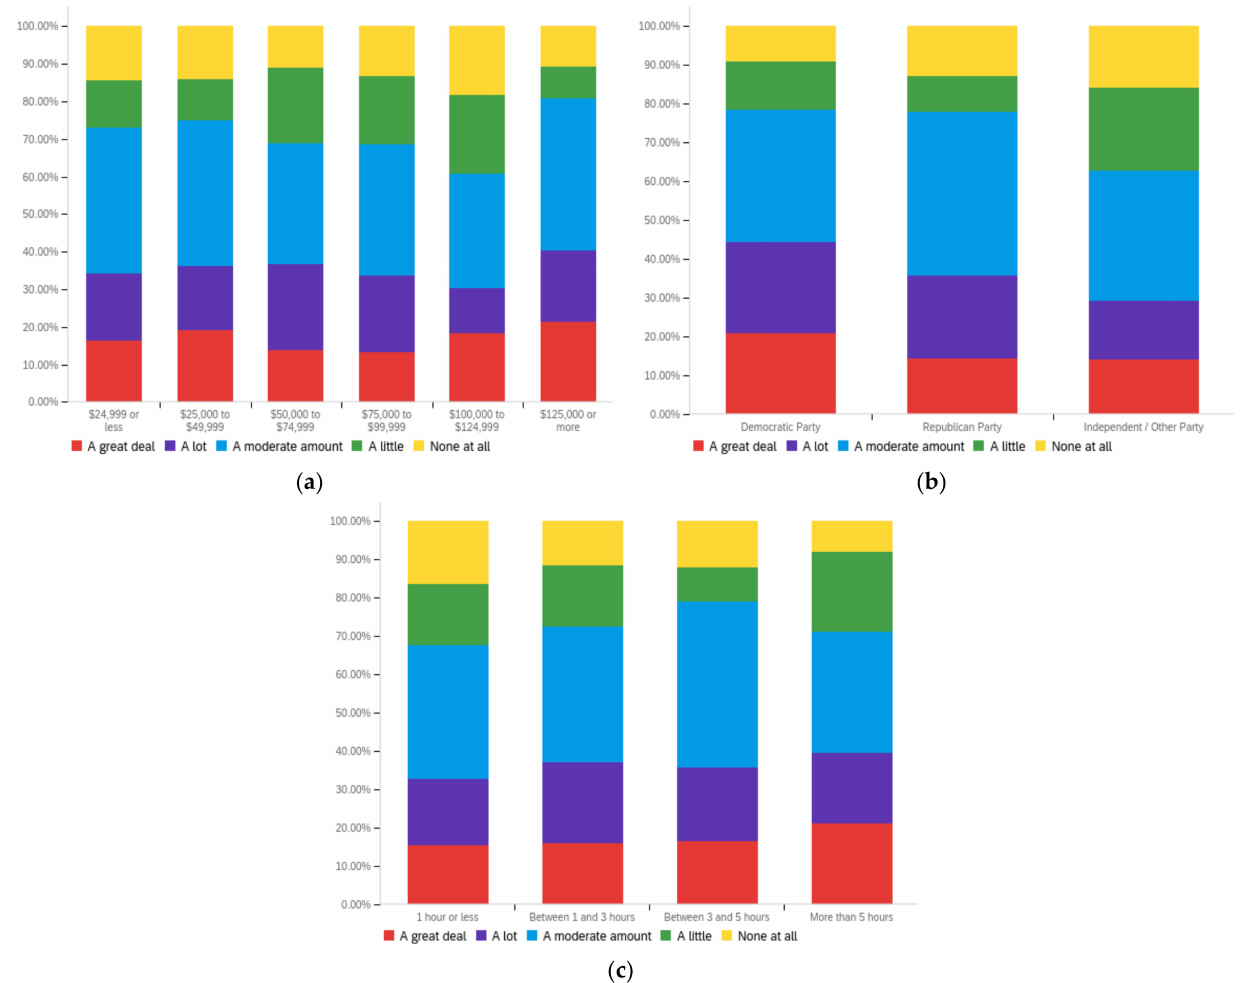
Figure A31. Article controversy level—personal perception impact by: ( a ) income level (top left), ( b ) political affiliation (top right) and ( c ) online usage (bottom).